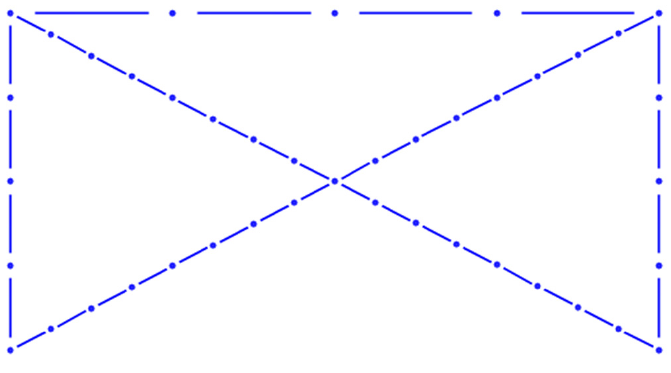
Figure 9. Representation of the discretization of the elements. correspondence to the nodal zones (Figure 10).